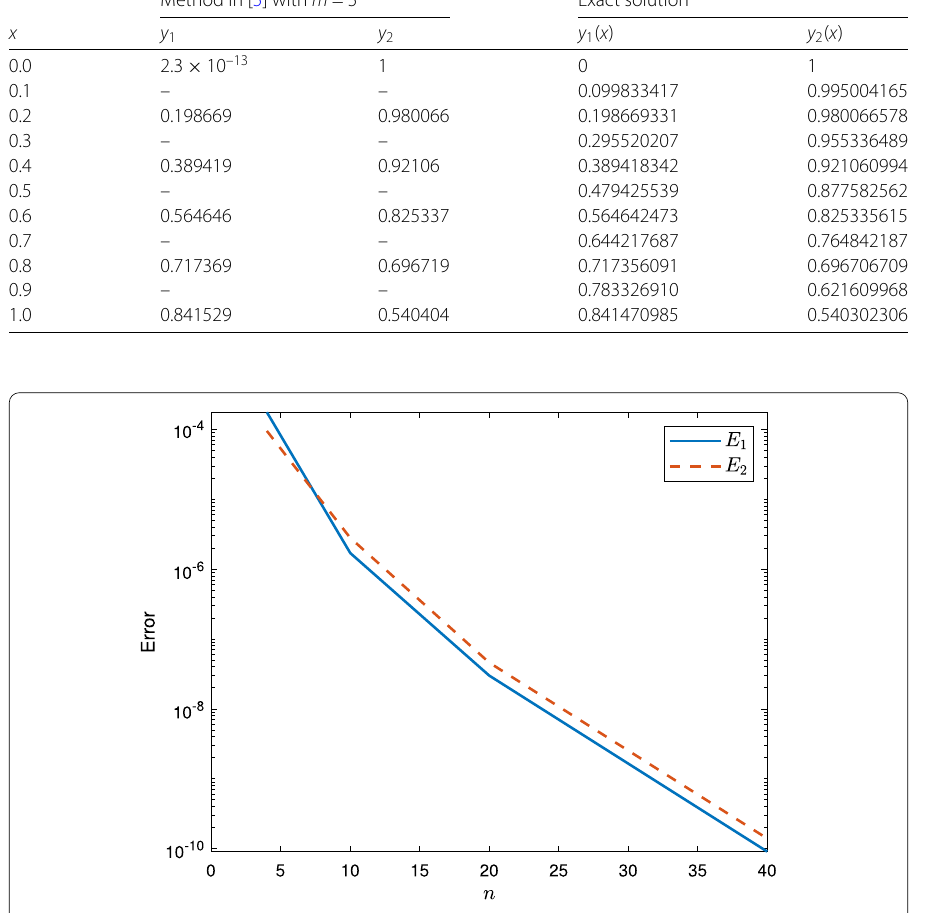
Figure 1 The log-plot of errors for Example 1 with w 1 = w 2 =